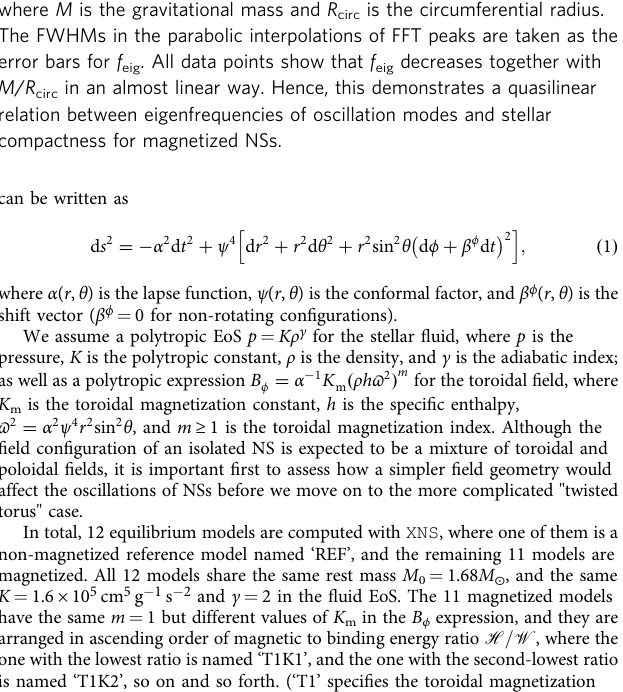
Fig. 4 Quasilinear correlation between eigenfrequencies of oscillation modes and stellar compactness. Eigenfrequencies f eig of the excited oscillation modes are plotted against compactness M / R circ of the NS model, where M is the gravitational mass and R circ is the circumferential radius. The FWHMs in the parabolic interpolations of FFT peaks are taken as the error bars for f eig . All data points show that f eig decreases together with M / R circ in an almost linear way. Hence, this demonstrates a quasilinear relation between eigenfrequencies of oscillation modes and stellar compactness for magnetized